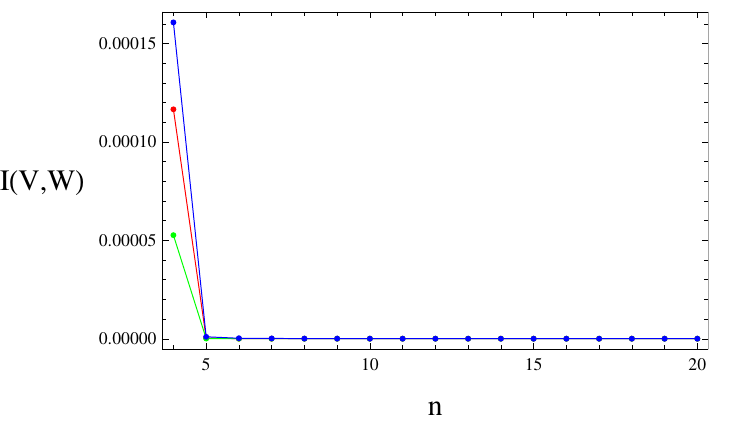
Figure 24 . The mutual information of gauge (cid:12)elds coupling with matter between two squares of equal sizes separated by a distance equal to the square size for algebra B ~ A with m = 1 line), m = 1 (red line) and m = 2 (green